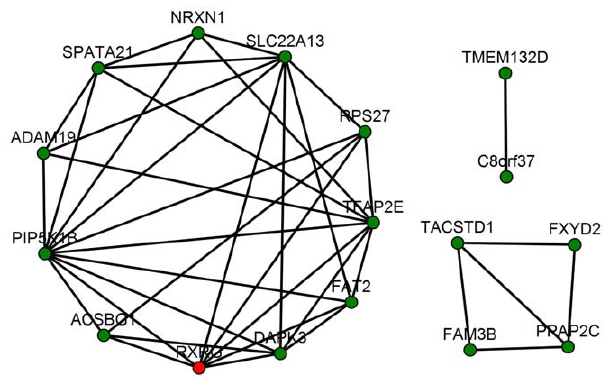
Figure 6. Sub-networks of genes with the most human-specific interactions. Node in red is RXRG . Nodes are connected by an edge if their co-expression relationship exists only in human, but not in mouse or